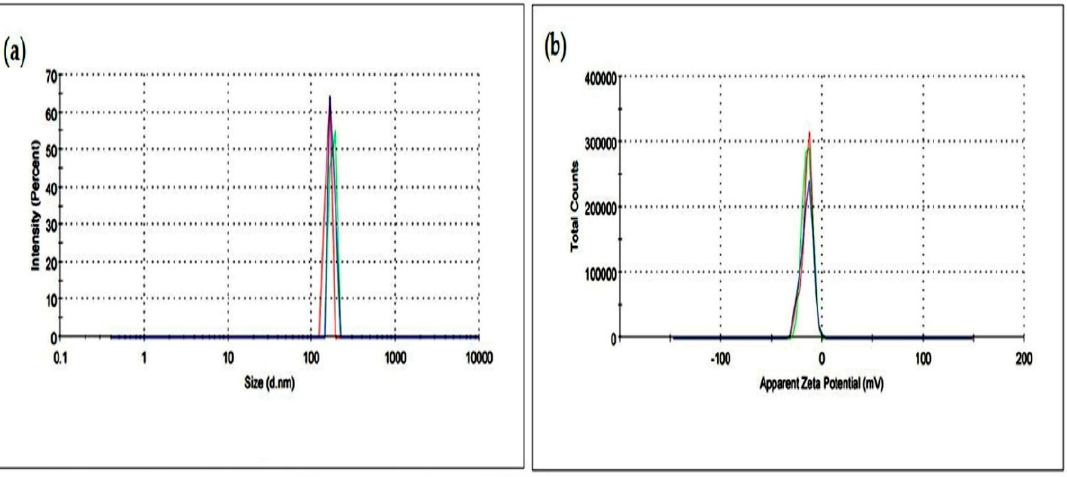
Figure 5. DLS Zetasizer analysis ( a ) Size distribution of the synthesized UD-AgNPs ( b ) Zeta potential of the synthesized UD-AgNPs.